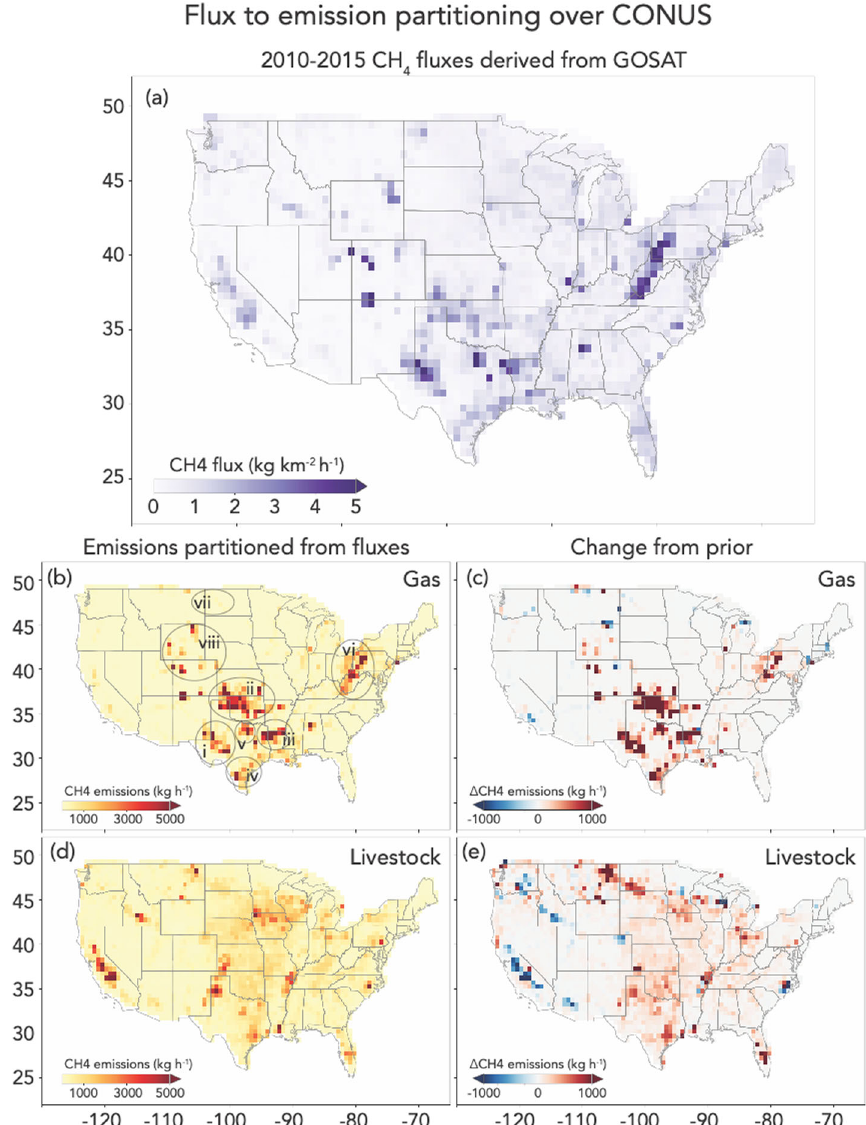
Fig. 1 Optimized total CH4 emissions per grid cell over CONUS using 2010 – 2015 GOSAT inverse fl uxes 6 . Panel a shows CH4 fl uxes at 0.5 × 0.625° resolution. Panels b and c show optimized emissions and the change from the prior for the gas sector, respectively at 0.1 × 0.1° resolution. Circled boxes in Panel b show rough outlines of major U.S. gas producing basins: (i) Permian, (ii) Anadarko, (iii) Haynesville, (iv) Eagle Ford, (v) Barnett Shale, (vi) Appalachia, (vii) Bakken, and (viii) Niobara. Panels d and e show optimized emissions and the change from the prior for the livestock sector,